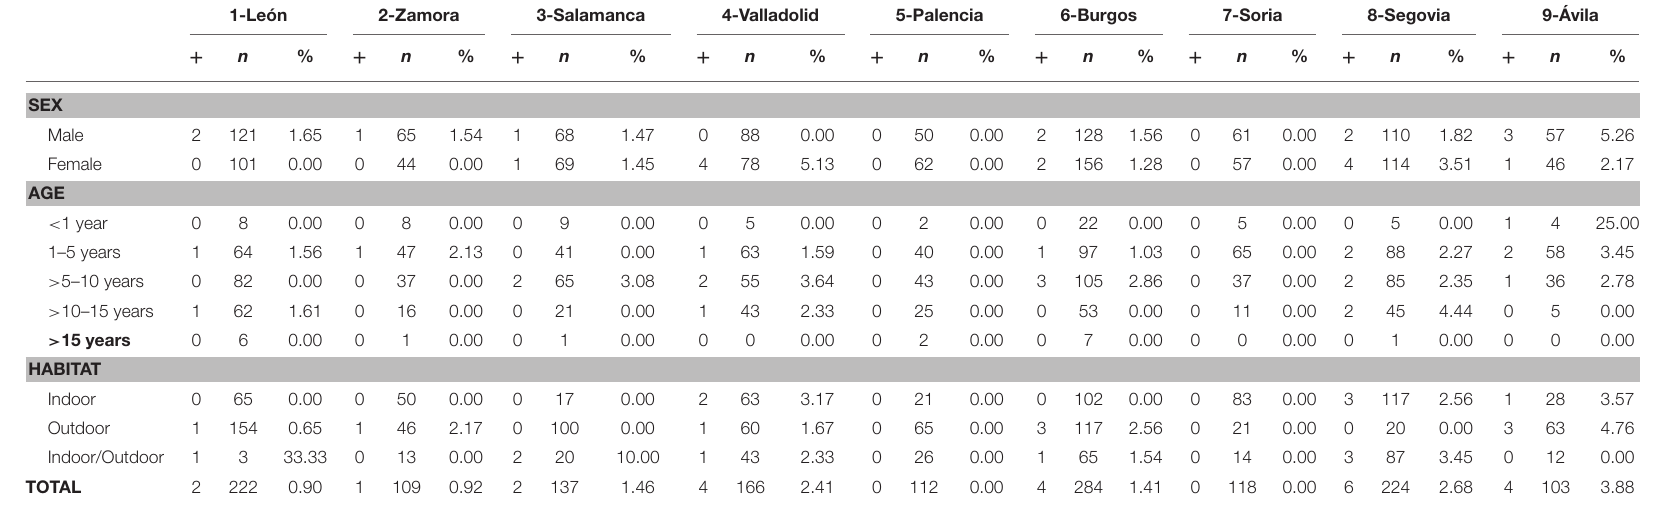
TABLE 4 | Numbers of dogs sampled and seroprevalence of A. platys by sex, age, and habitat in the nine provinces of Castilla y León,